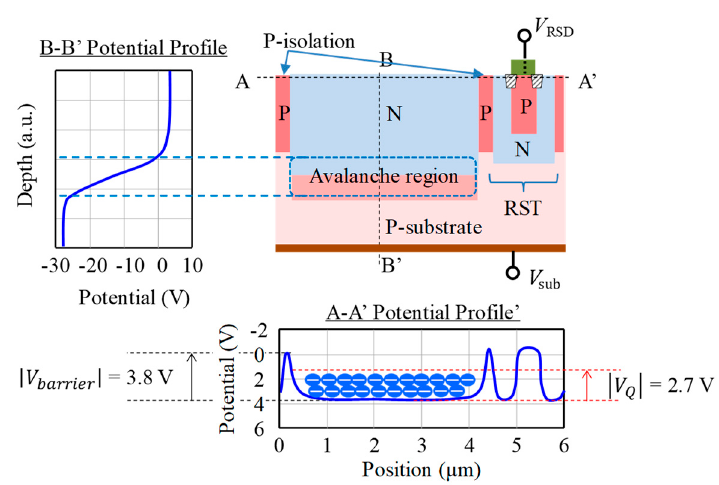
Figure 4. A cross sectional view of a SPAD with a vertical avalanche photodiode structure (VAPD) and the designed potential profiles in the horizontal (A-A’) and the vertical (B-B’) direction. The transistor shown on the cross section represents the reset transistor (RST), in Figure 1a.